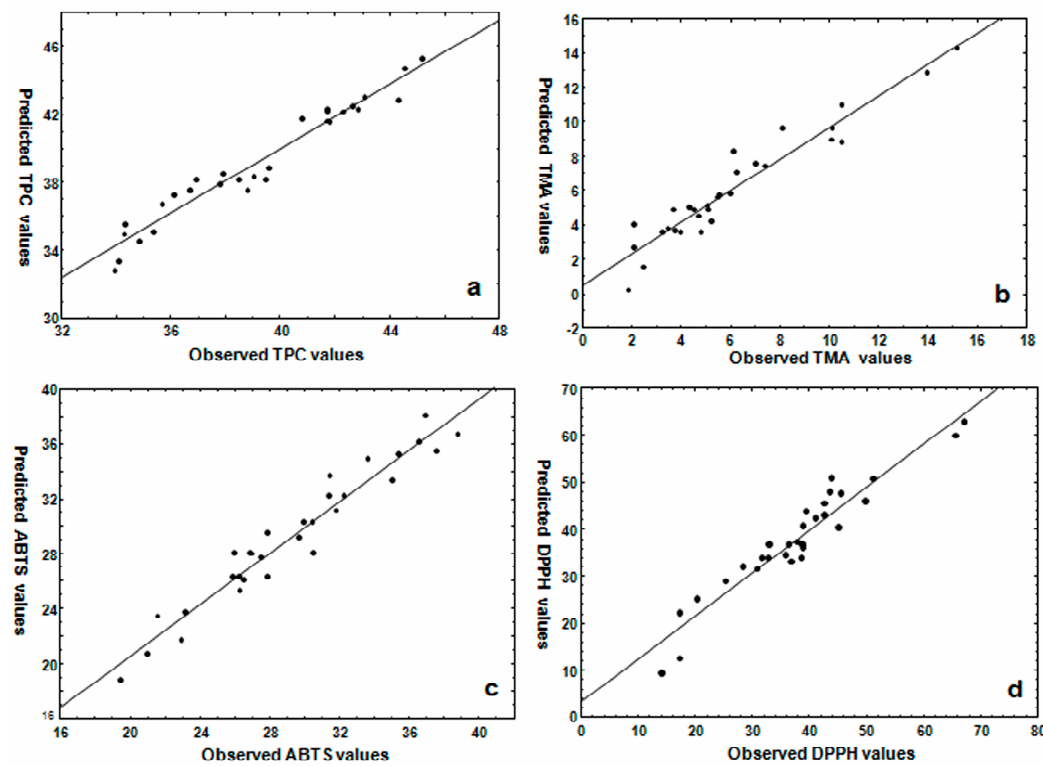
Figure 2. Scatterplot of predicted and observed value of ( a ) total soluble phenol content (TPC); ( b ) total monomeric anthocyanin (TMA); ( c ) ABTS; and ( d ) DPPH of the leaf extract of Brosimum alicastrum .